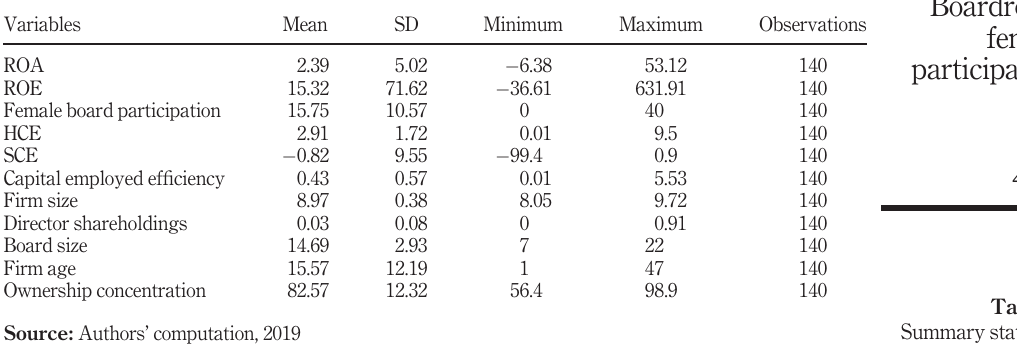
Table I. Summary statistics